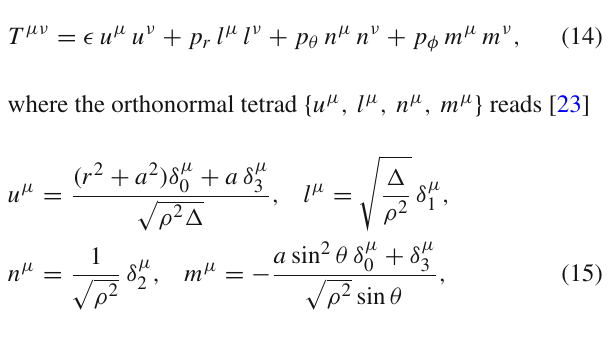
however this is maximum at the poles, in agreement with Eq. (16). The plot on the right shows the inner box region magnified. We take a = 0 . 9 and (cid:2)/κ =